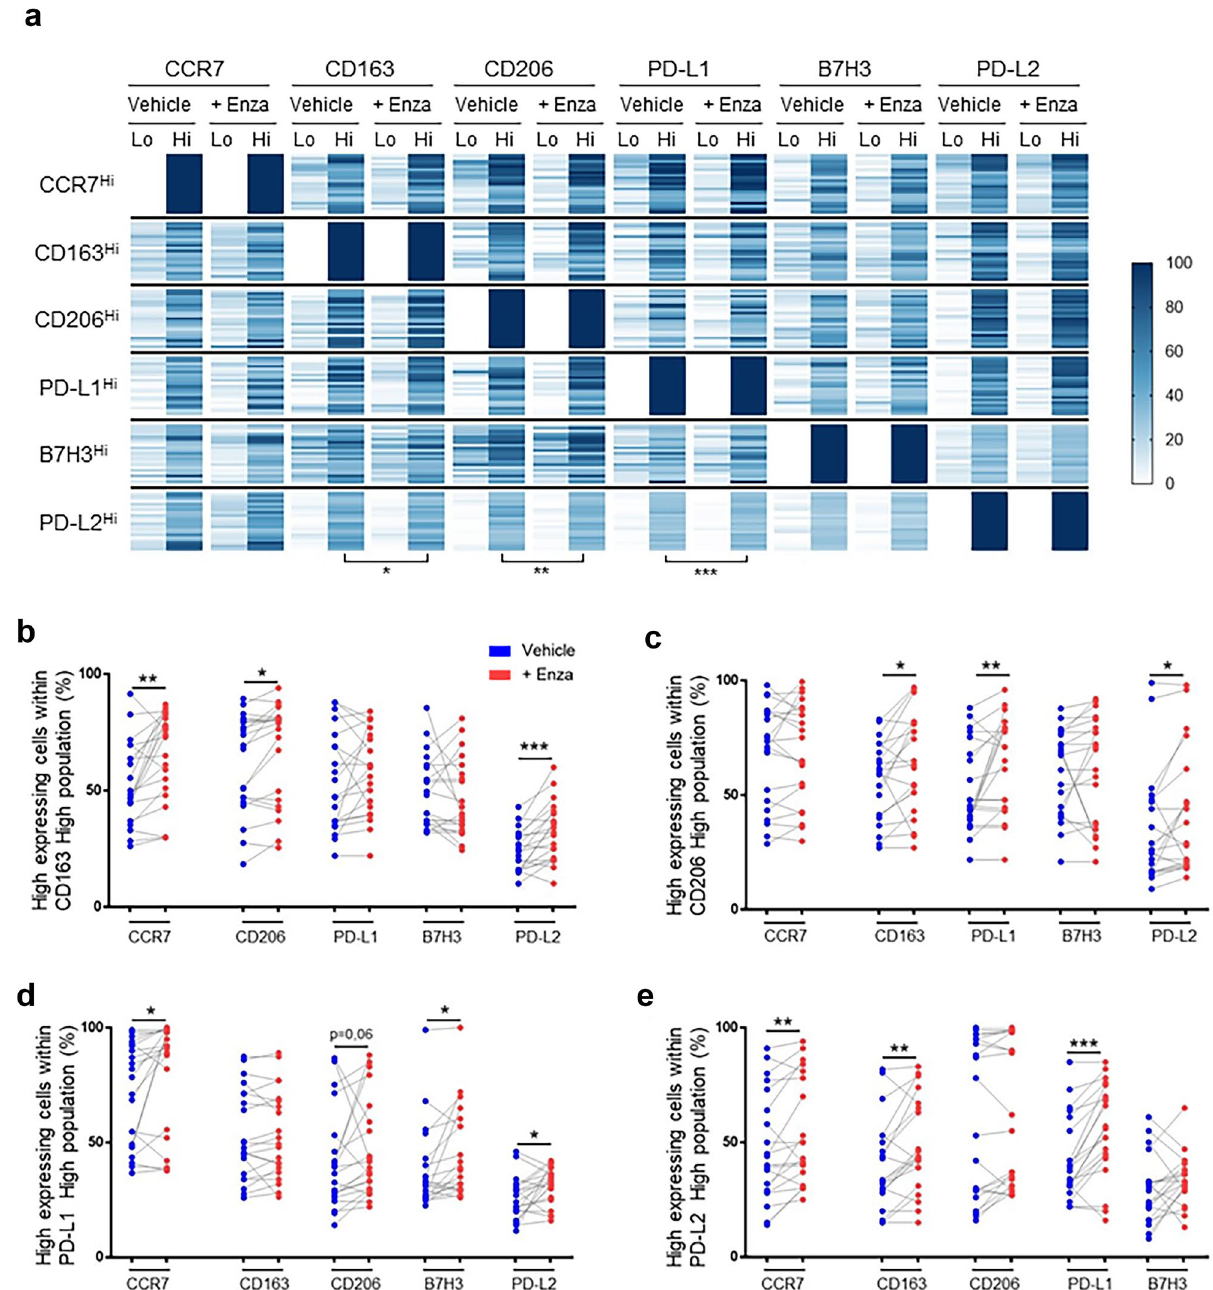
Figure 4. Enzalutamide treatment of prostate cancer biopsies induces changes in detailed macrophage landscape. For each patient, the expression of M1(CCR7) and M2 (CD163, CDD206, PD-L1, PD-L2) markers was quantified within macrophage (CD45 + /CD11b + /HLA-DR + ) clusters defined by manually gated high and low expression of indicated marker. Scale bar indicates frequency of high expression from 0 to 100% of the indicated markers. Overall, there were significant increases in CD163, CD206 and PD-L1 expression across all high- expressing marker macrophage clusters as summarized in a heatmap. ( a ). Details of changes in high-expressing CD163-, CD206-, PD-L1- and PD-L2- macrophages clusters for paired enzalutamide-treated and control samples ( b – e ). n = 21, paired and non-paired Student’s T-test, *p < 0.05, **p < 0.005, ***p <